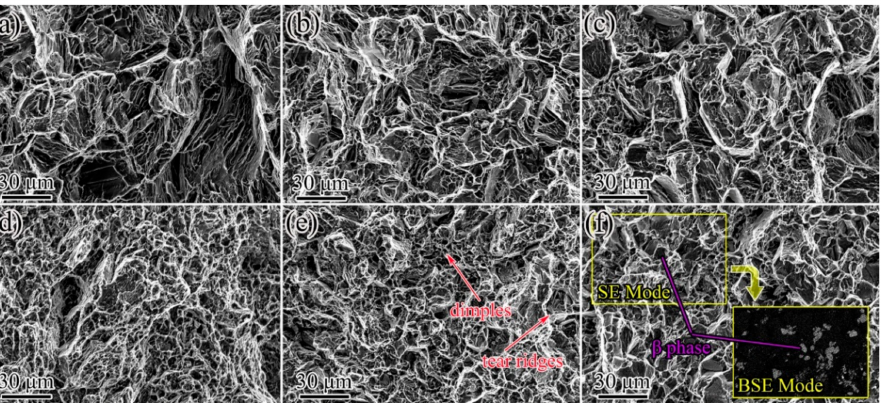
Figure 8. Tensile test of fracture microstructure of the IEECAPed and subsequently aged Mg-xNd- 2.0Sm-0.4Zn-0.4Zr alloys with different Nd content (wt.%): ( a ) 0, ( b ) 0.5, ( c ) 1.0, ( d ) 1.5, ( e ) 2.0 and ( f )